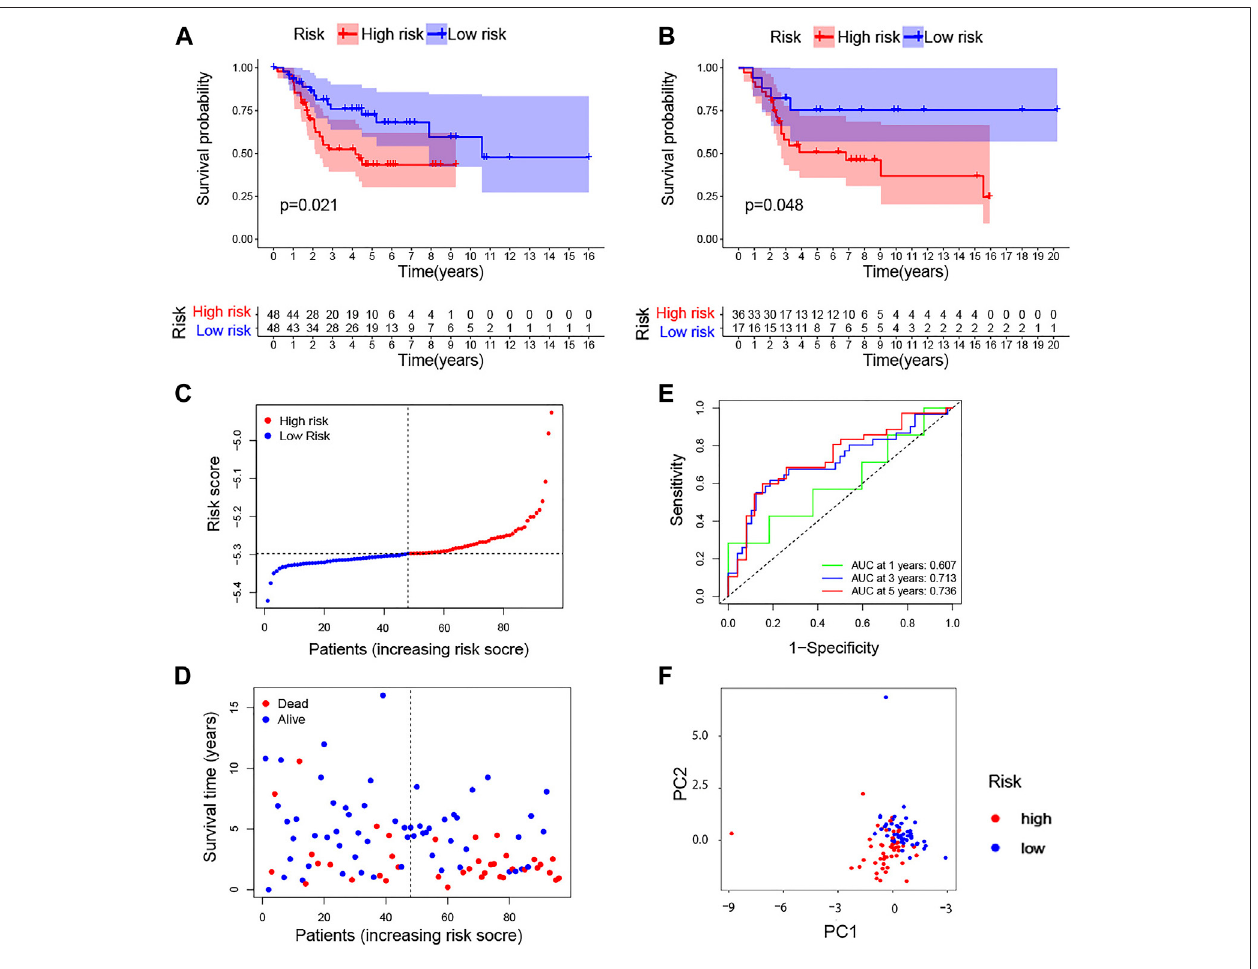
FIGURE 4 | TcoF-related gene prognostic risk score model. (A,B) Survival analysis to verify the prognostic model based on TARGET and GSE21257. (C) Distribution of risk scores of each osteosarcoma patient. (D) Osteosarcoma patients ’ survival time according to the risk score model. (E) Time-dependent ROC curves for osteosarcoma patients based on TARGET. (F) PCA plot for osteosarcoma patients based on the risk score based on TARGET. PCA, principal component analysis.